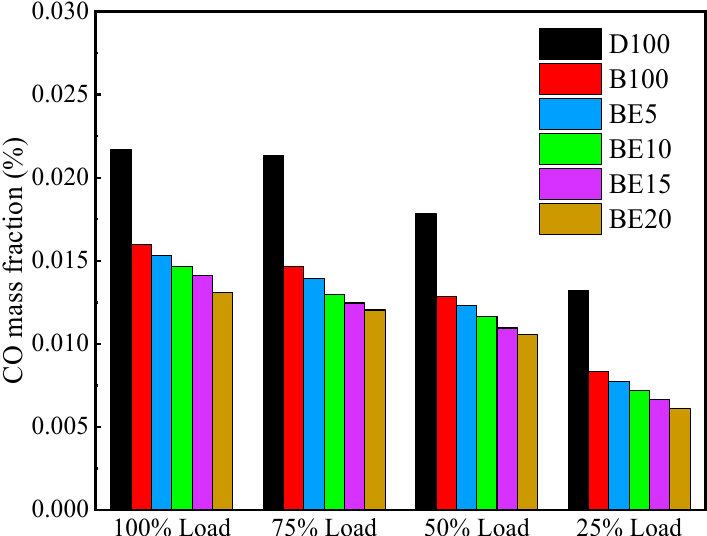
Figure 15. Comparison of CO emission for different blended fuels at different loads.